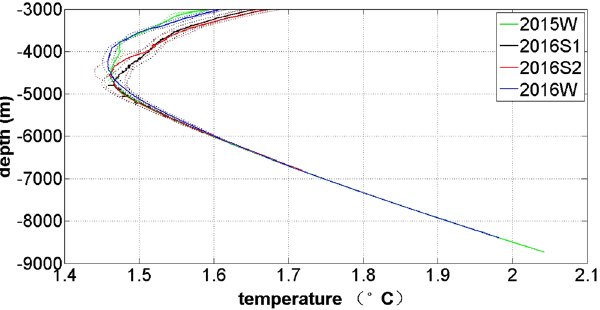
Figure 3. Vertical profiles of mean temperature. Vertical profiles of mean temperature below 3000 m measured at the stations during 2015W (green lines), 2016S1 (black lines), 2016S2 (red lines), and 2016W (blue lines). The dots indicate mean temperature ± standard deviation. This was generated using MATLAB.